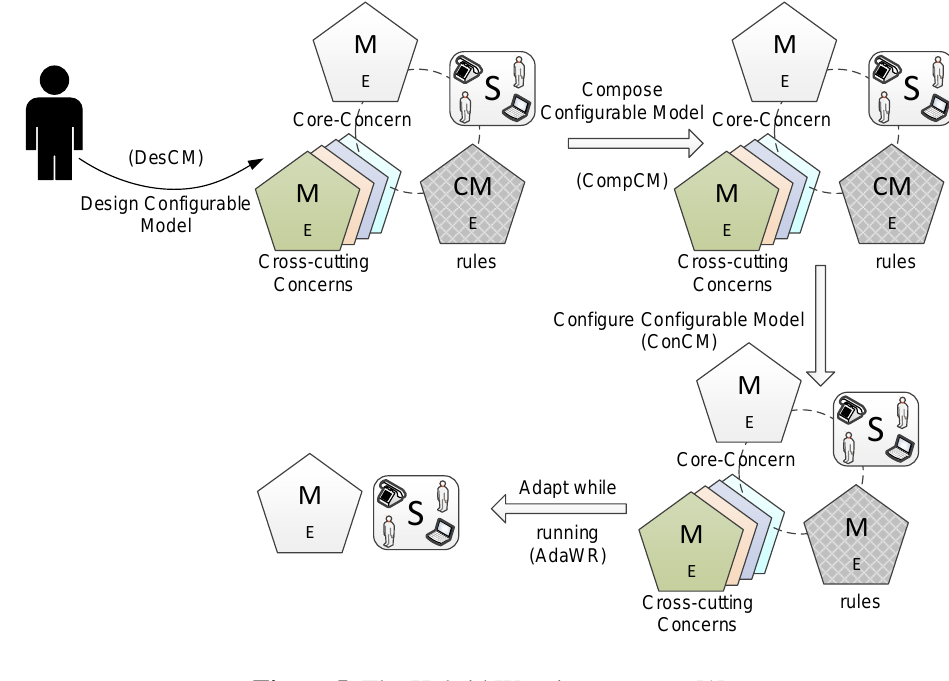
Figure 5. The Hybrid Weaving use case